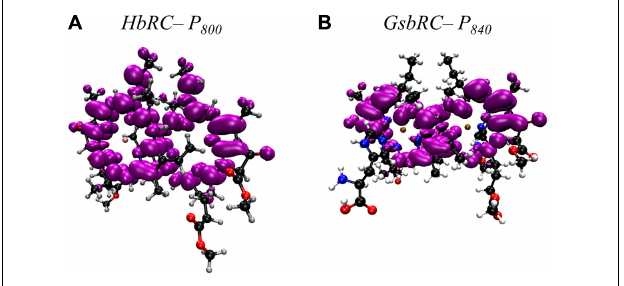
FIGURE 11 | Electron spin density distribution on the Chl 1A macrocycles of the homodimeric oxidized primary donor (A) P 800 ·+ of the HbRC from Heliobacterium modesticaldum (PDB ID: 5v8k) (Gisriel et al., 2017) and (B) P 840 ·+ of the GsbRC from Chlorobaculum tepidum (PDB ID: 6m32) (Chen et al., 2020) in the singly occupied molecular orbital (SOMO) as determined through DFT